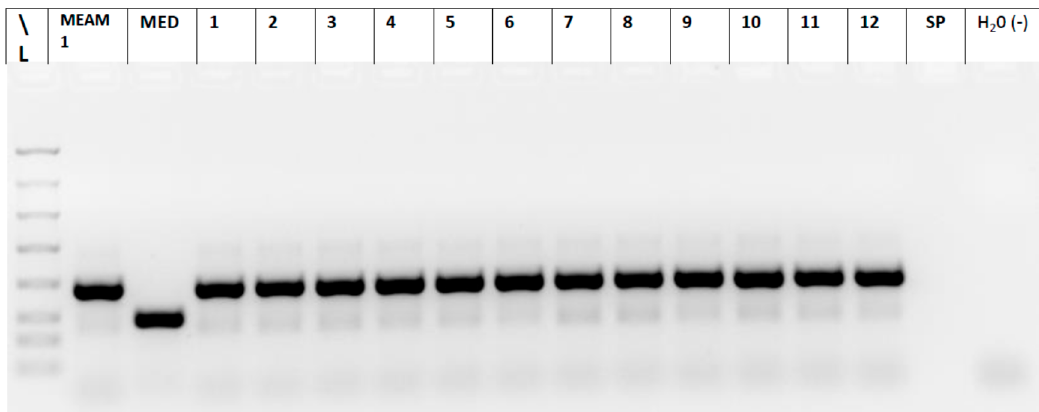
Figure 2. Amplification of Bemisia tabaci mtCOI with biotype specific primers to distinguish the B